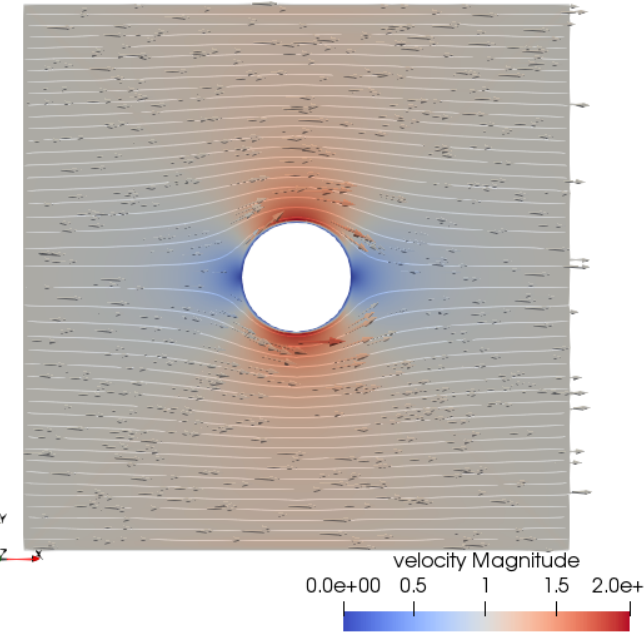
Figure 11. Case 1: the velocity representation with stream lines for domain h 1 -refinement.